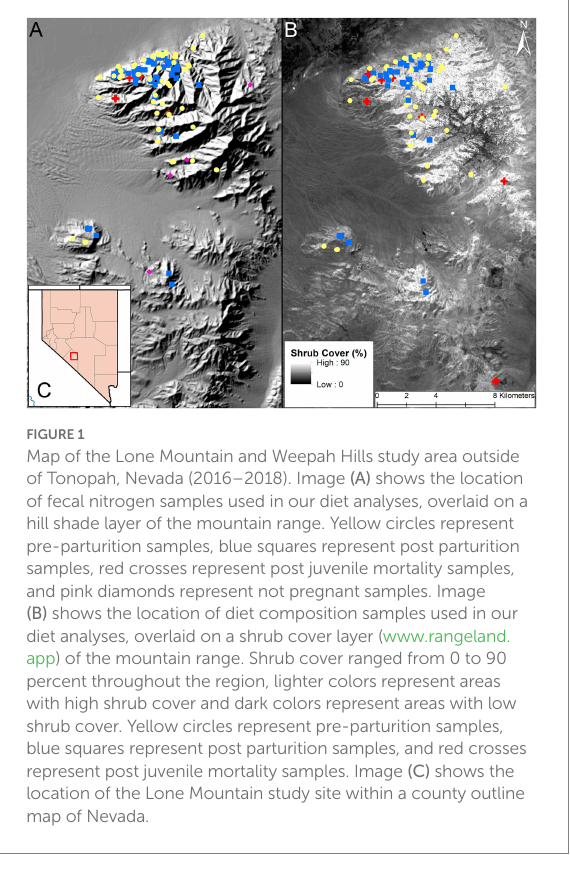
annual average of 11.8 cm (SD = 1.6 cm) of precipitation and 60.1 cm (SD = 48.2 cm) of snowfall throughout the duration of